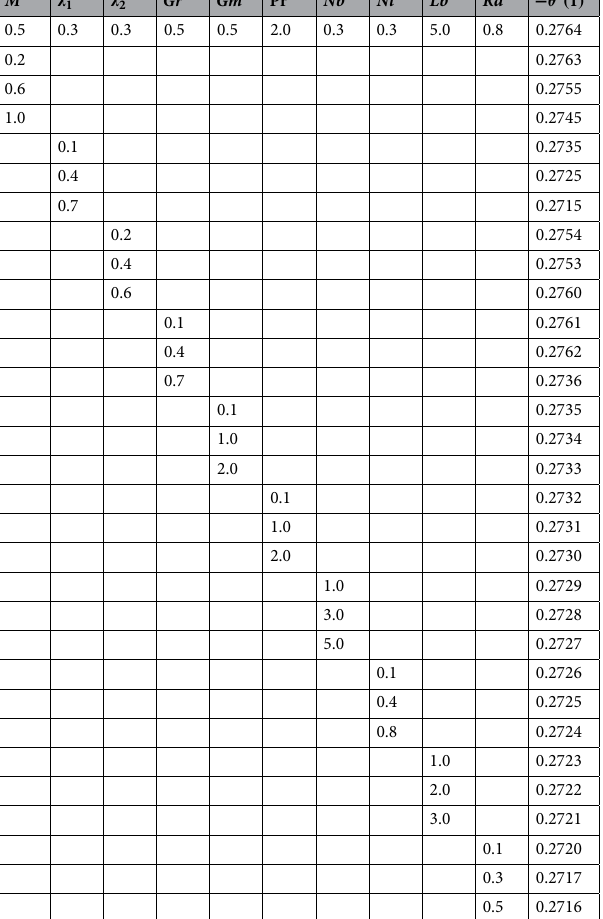
θ ′ ( 1 ) for M , (cid:31) 1 , (cid:31) 2 , Gr , Gm , Pr, Nb , Nt , Lb and Rd −